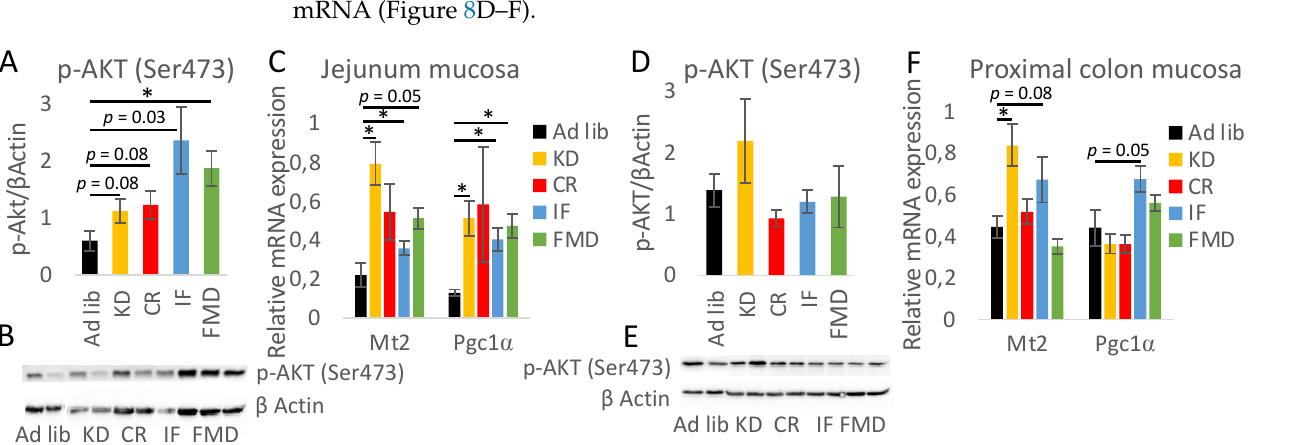
Figure 8. Restrictive diets affect the expression of CR-related factors. The protein level of phosphorylated AKT (p-AKT (Ser473)) was assessed in the mucosa of the jejunum ( A , B ) and proximal colon ( D , E ). Gene expression of Mt2 and Pgc1 was measured in the mucosa of the jejunum ( C ) and colon ( F ). Statistical differences were assessed with ANOVA and by Tukey’s post hoc test. * p < 0.01; n = 6–8. Data are presented as the mean ± SEM.